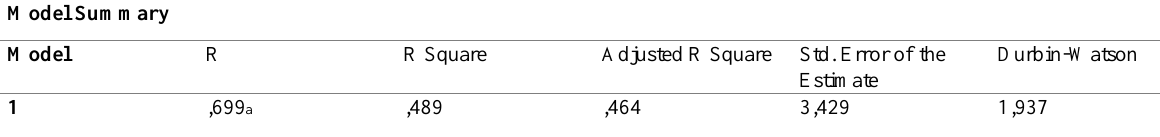
Table 3: Model Summary and